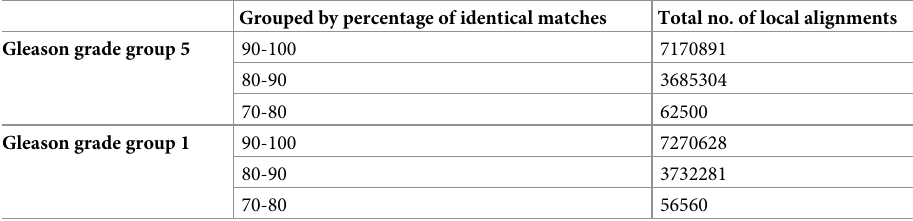
Table 1. Sequence similarity within a Gleason grade group of 5 and 1 for BRCA 1 blood DNA sequences. Grouped by percentage of identical matches